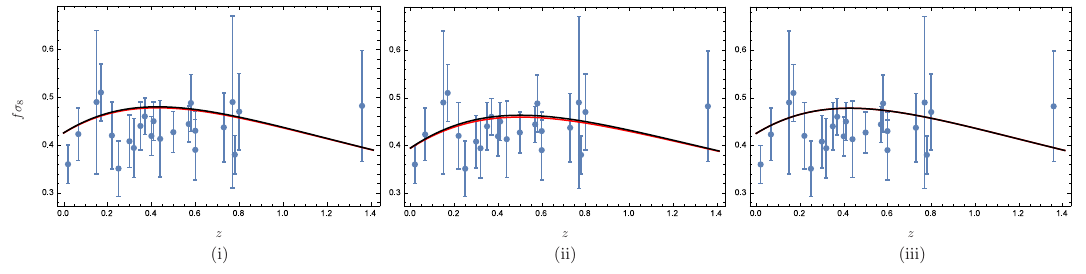
Figure 3. The evolution of f σ 8 in terms of the redshift for each model (black curve) together with the corresponding Λ CDM model (red curve). The blue dots and corresponding error bars indicate observational values ( please, see [33] and references